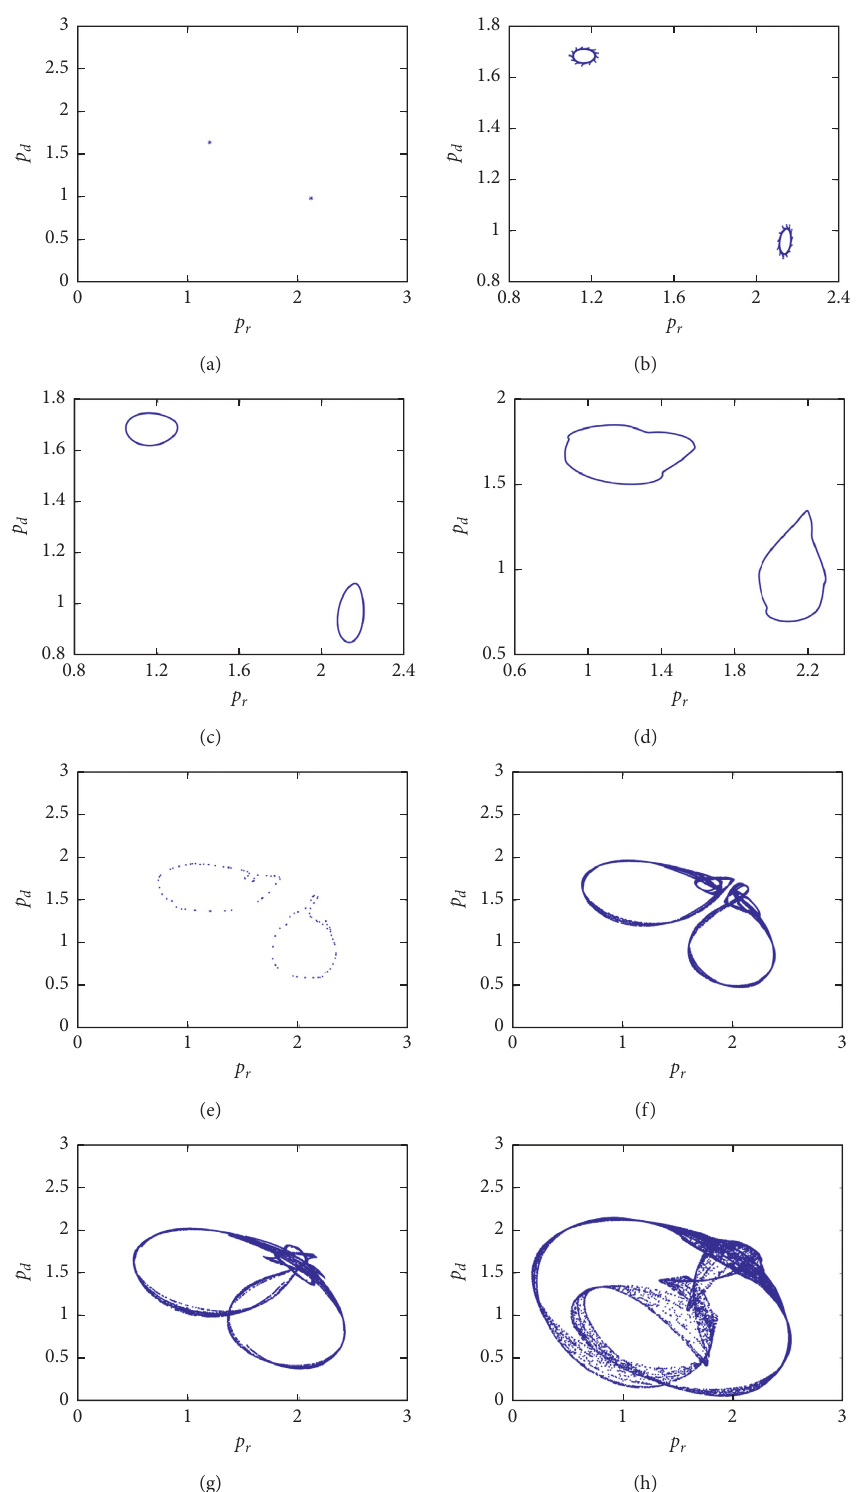
Figure 5: Diagrams of attractors evolution. (a) β � 0 . 5827, (b) β � 0 . 6277, (c) β � 0 . 6357, (d) β � 0 . 6887, (e) β � 0 . 7247, (f) β � 0 . 7487, (g) β � 0 . 7747, and (h) β � 0 .